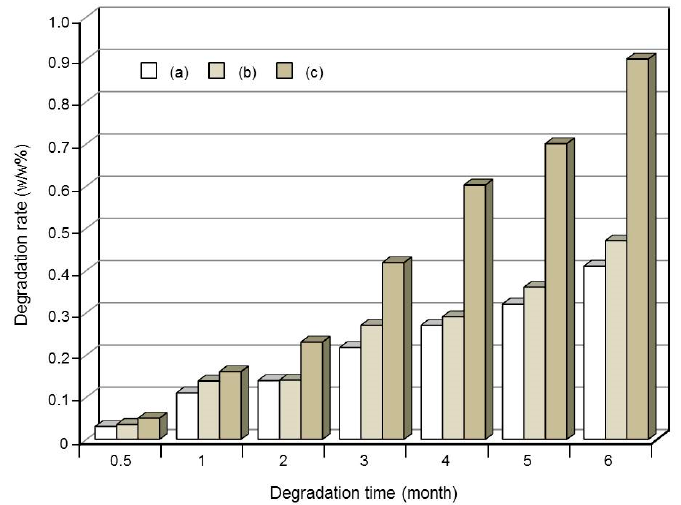
Figure 7. The degradation rate % (w/w) calculated from the weight loss of the fibers in PBS (1M, pH 7.2) at 37 °C: ( a ) original PLA fiber; ( b ) P-3 and ( c ) P-4.